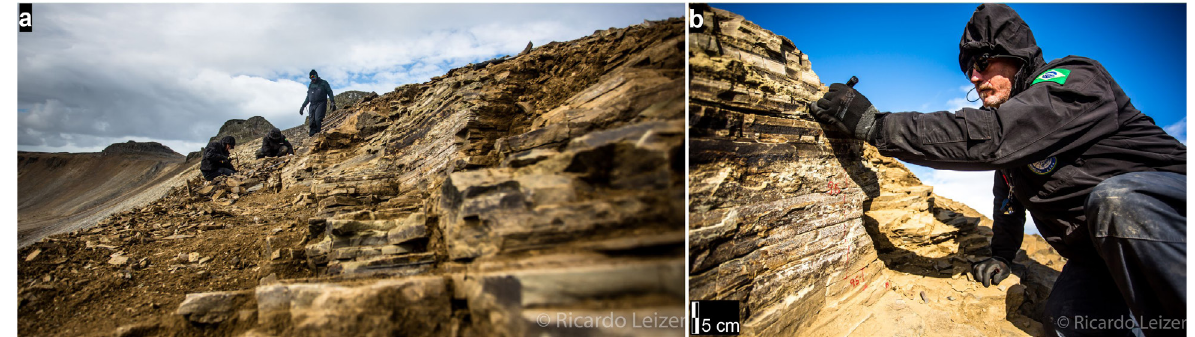
Figure 2. Outcrop photographs. a) General view of the studied area that is mostly covered by regolith. b) Stratigraphic profiling